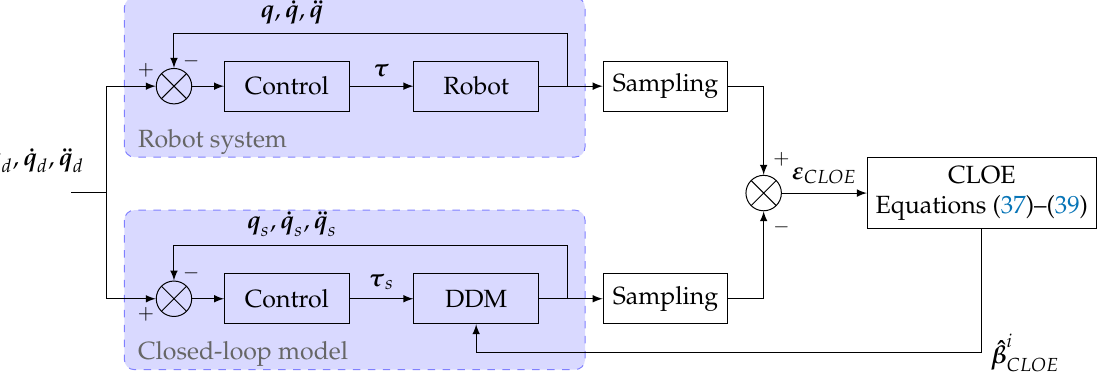
Figure 2. Block diagram of the CLOE identification